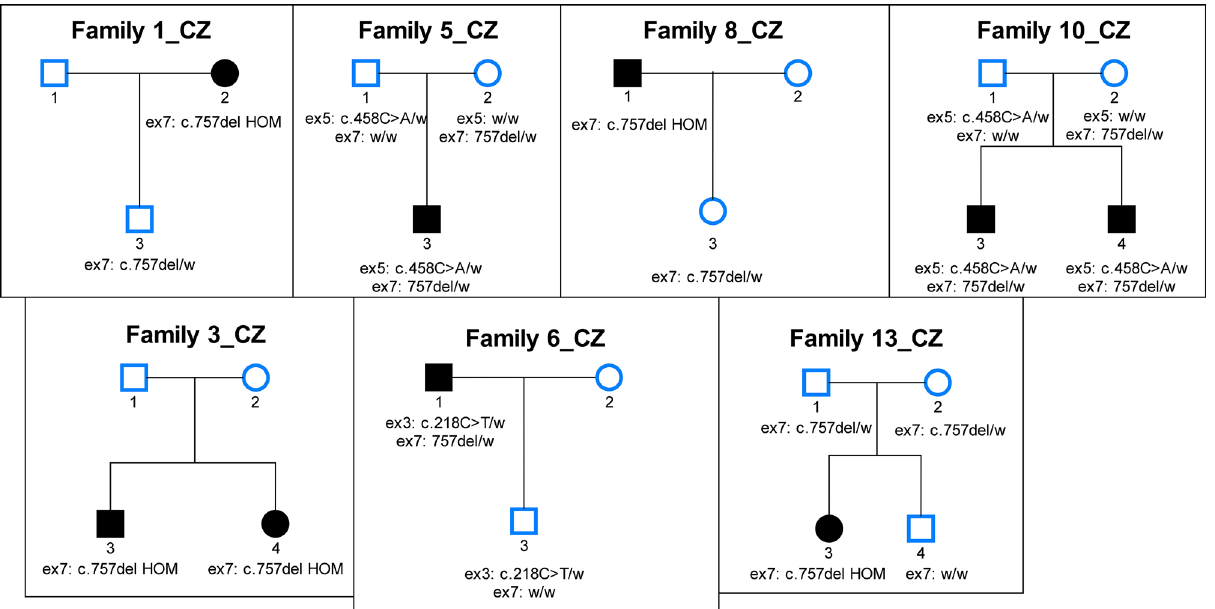
Figure 4. The pedigrees of selected families. HOM homozygous, w wild type; Pedigrees for families where at least two family members were tested are